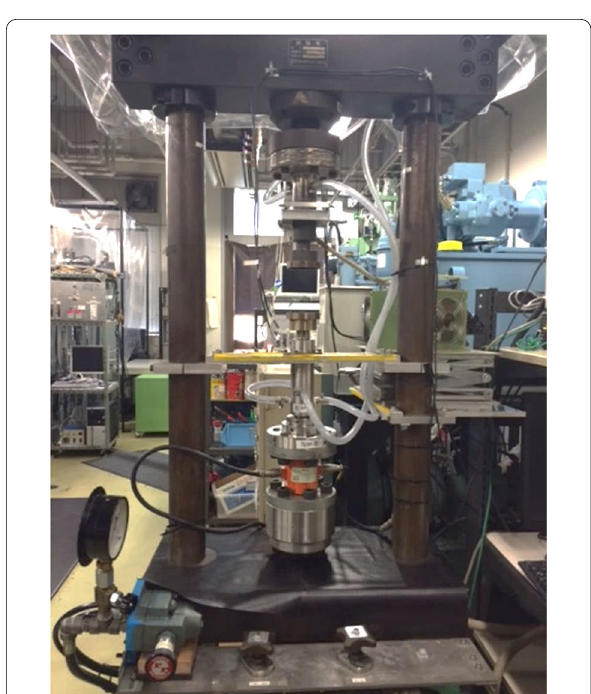
Figure 3 Photographic image of the fatigue testing machine